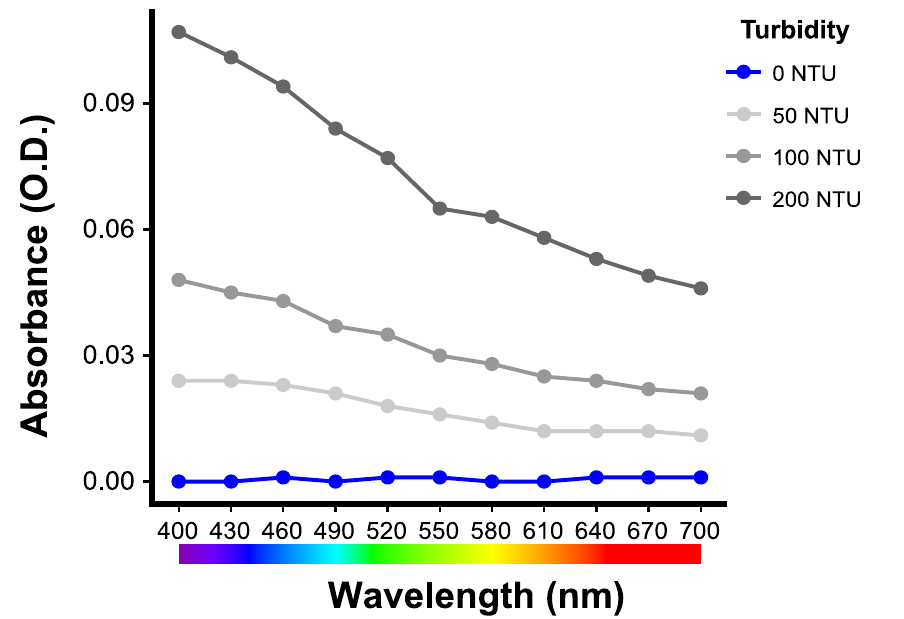
Fig 2. Absorbance spectra from 400 nm to 700 nm of the four turbidity treatments in this study.